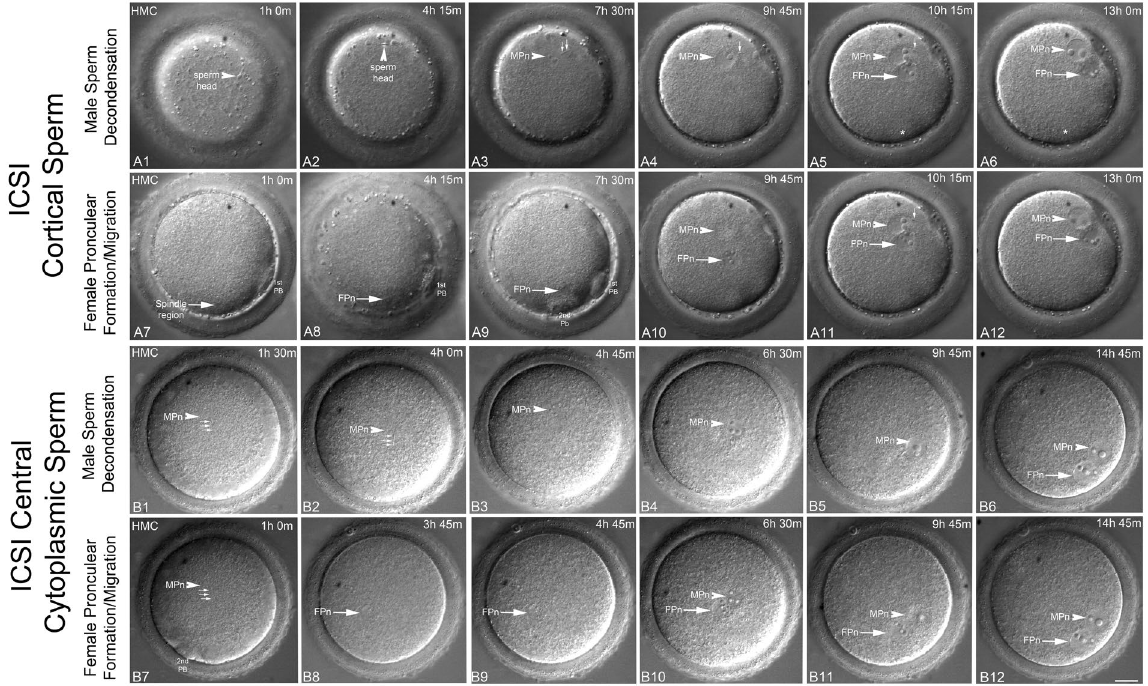
Figure 2. Selected TLVM panels of NHP sperm head decondensation, pronuclear assembly, migration and orientation following ICSI. ( A1 – A12 ). FPn and MPn formation, apposition, and cytoplasmic orientation by mid-interphase. Following ICSI, the cortically residing sperm head is visible translocating along the cortex, probably by cytoplasmic flow ( A1 – A2 , arrowheads). Sperm head decondensation into an MPn is observed cortically ( A3 – A4 , arrowheads) as the sperm aster assembles and promotes FPn migration ( A5 : MPn, arrowhead; FPn, arrow). Apposed FPn and MPn are oriented para-tangentially to the overlying cortex and obliquely to the A → V axis ( A6 : MPn, arrowhead; FPn, arrow; 2 nd PB position out of focal plane marked with * ). FPn formation following elicitation of the second polar (2 nd PB) is observed in ( A7 – A9) (arrows) with migration to the cortical MPn and tangential positioning at the cortex seen in A10–A12 (arrows; FPn, female pronucleus; MPn, male pronucleus). ( B1 – B12 ). FPn and MPn events after sperm deposition in the central cytoplasm. After central cytoplasmic sperm deposition by ICSI, the sperm head undergoes decondensation ( B1-B2 , arrowheads; small arrows, incorporated sperm axoneme) as the developing MPn jostles within the central cytoplasm ( B2-B4 ; arrowheads). The FPn migrates along sperm astral microtubules to arrive at the MPn ( B4 , arrowhead) and the apposed parental genomes translocate to the oolemma cortex, aligning para- tangentially to the zygote surface and obliquely to the A → V axis (2 nd PB in B7 ). FPn forms after 2 nd PB formation ( B7 – B9 : arrows) and completes migration to the decondensed MPn by 6.5 hr post insemination ( B10 : FPN, arrow; MPn, arrowhead). Over the next 8 hrs, the apposed parental genomes translocate to the cortex ( B11-B12 ; FPn, arrow; MPn, arrowhead). The small arrows trace the sperm axoneme in ( A3 – A5 , A11 , B1 , B2 , B7) . Time is given in hours:minutes (h:m) post ICSI. All panels represent selected HMC images from a TLVM recording. Bar = 20 µ